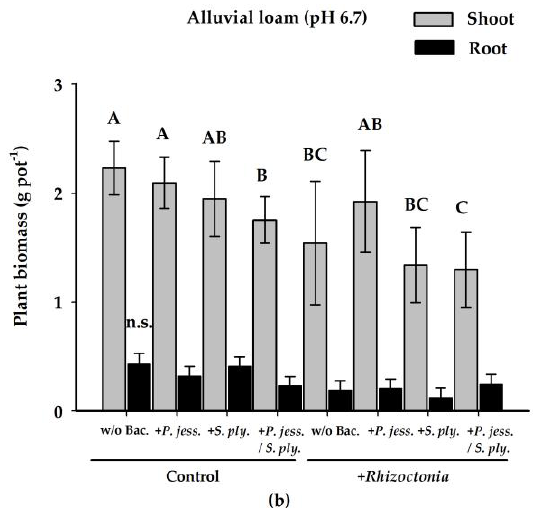
Figure 1. Habitus ( a ) and shoot and root dry mass (g pot −1 ) ( b ) of Lactuca sativa L. cv. Tizian. The plants were grown on alluvial loam without bacterial inoculation (w/o Bac.), pre-inoculated with Pseudomonas jessenii RU47 ( +P. jess. ), Serratia plymuthica 3Re-4-18 ( +S. ply. ), a combination of both ( +P. jess/S. ply. ), with and without (Control) subsequent inoculation with Rhizoctonia solani AG1-IB (+ Rhizoctonia ). Means ± standard errors of four independent replicates. Different characters indicate significant differences (one-way ANOVA, Holm-Sidak test, p = 0.05).